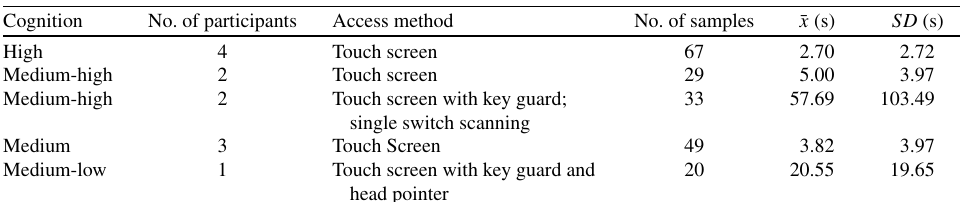
Table 3 User selection: Motor times for 198